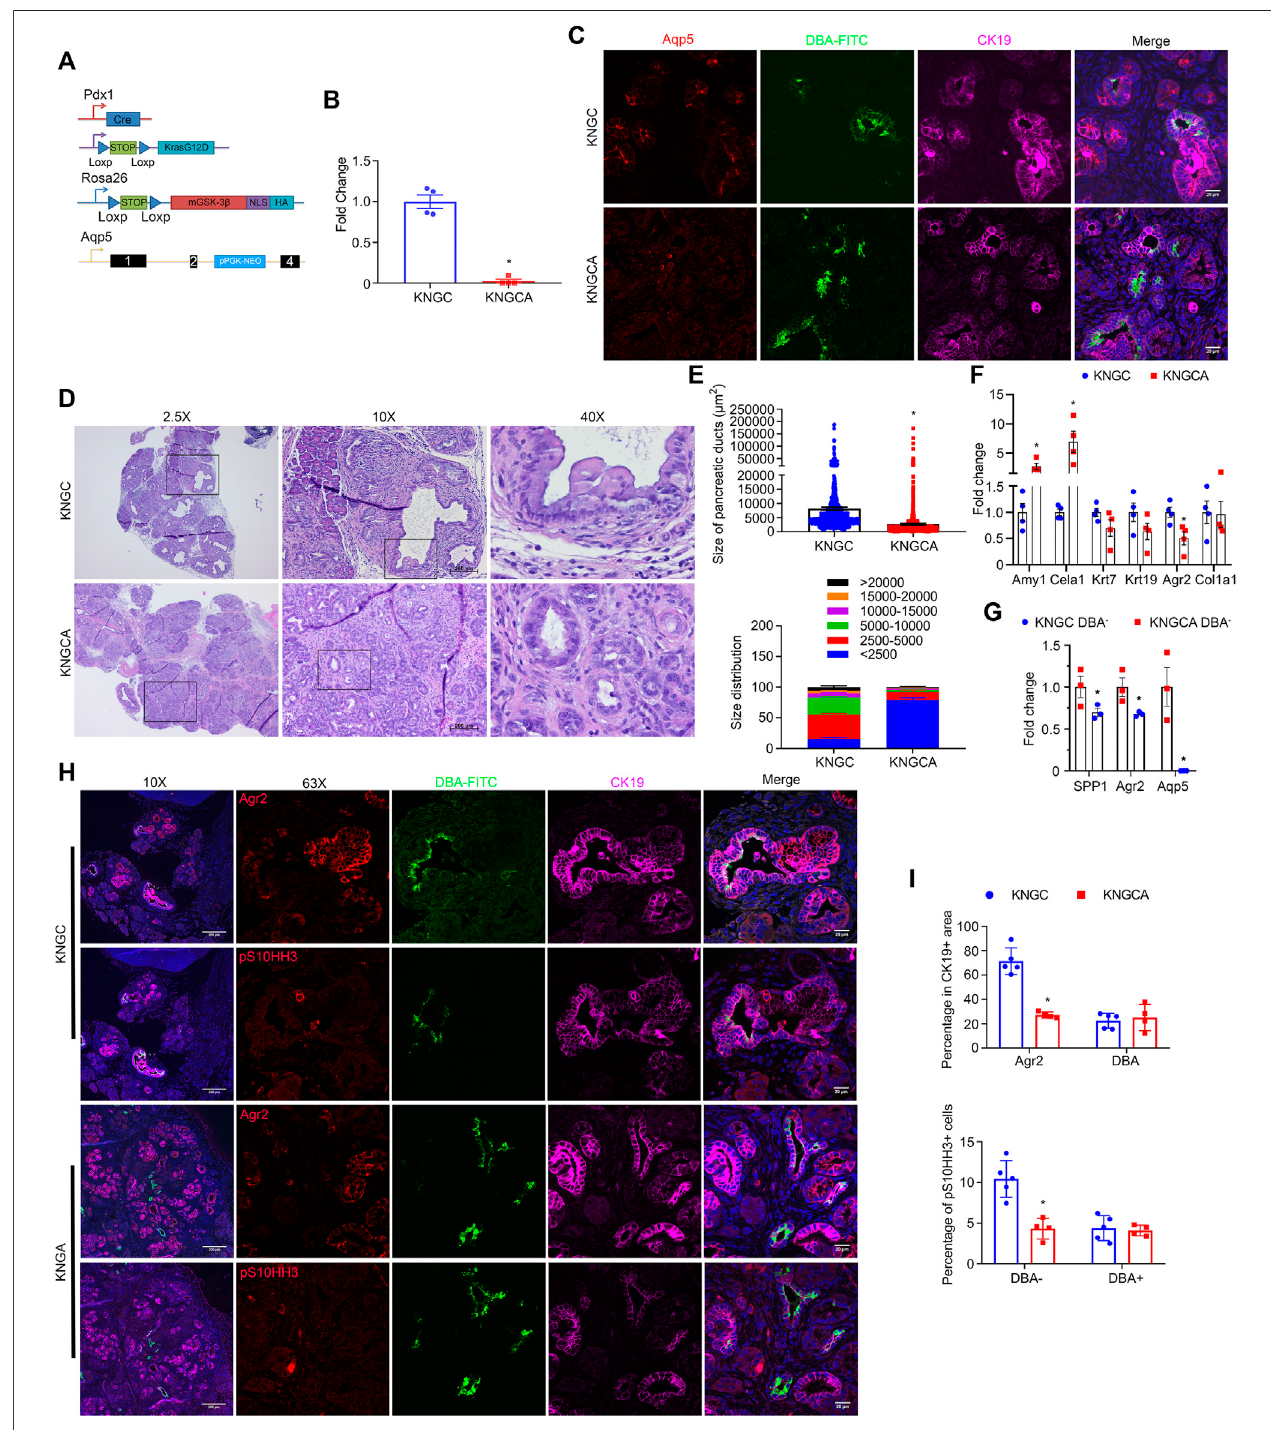
FIGURE5| Aqp5isnecessaryforthedifferentiationandgrowthofterminalductsinKNGCmice. (A) SchematicrepresentationofKNGCA(LSL-KRas G12D /Rosa26- LSL-nuclear GSK-3 β /Pdx1-Cre/Aqp5 knockout) mouse model. Blue triangles indicate loxP sites. Black rectangles indicate exons of aqp5 gene. (B) Real-time PCR quanti fi cationofAqp5geneexpressionfrom4-week-oldKNGCandKNGCAmice.TBP, β -actin,RPLP0andGAPDHwereusedasinternalhousekeepinggenecontrols. Datawereanalyzed andexpressed asmean±SEM. p p < 0.05KNGCAversusKNGCmice. (C) Immuno fl uorescencestainingofAqp5 (red),DBA-FITC(green)and CK19 (purple) from pancreatic sections of 4-week-old KNGC and KNGCA mice. (D) H&E-stained pancreatic sections from KNGC and KNGCA mice. Black boxes indicated area magni fi ed. Bars = 200 μ m. (E) Quanti fi cation of pancreatic ducts size distribution and average pancreatic duct size were analyzed and expressed as mean ± SEM. n = 3. p p < 0.05 KNGCA versus KNGC mice. (F) Real-time PCR quanti fi cation of the indicated genes expressions from 4-week-old KNGC and